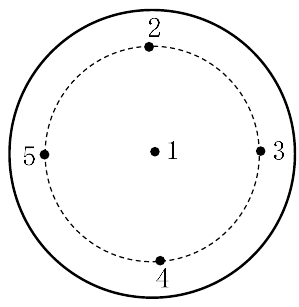
Figure 8. Schematic diagram of measuring points on sapphire wafer surface.